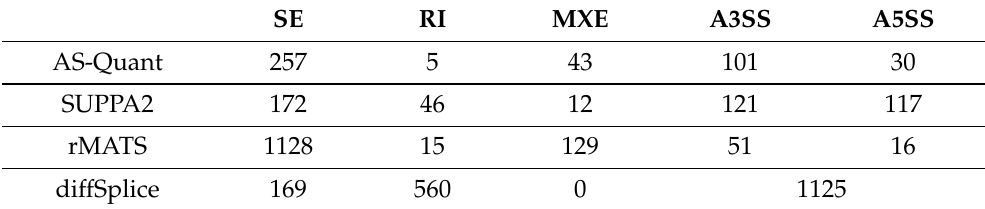
Figure 3. Simulation experiment to assess the performance of AS-Quant on different read depths. The ROC curves for the results of different RNA-seq read depth are plotted. Table 3. Number of alternative splicing events identified by AS-Quant and three baseline methods between Tsc 1 − / − MEFs with control and siU2af1. diffSplice cannot separate A3SS and